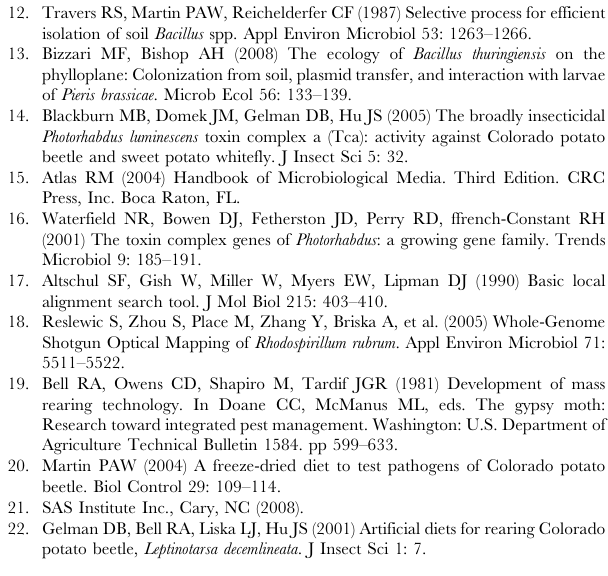
Table S2 Sequence types included in the phylogenetic analysis.